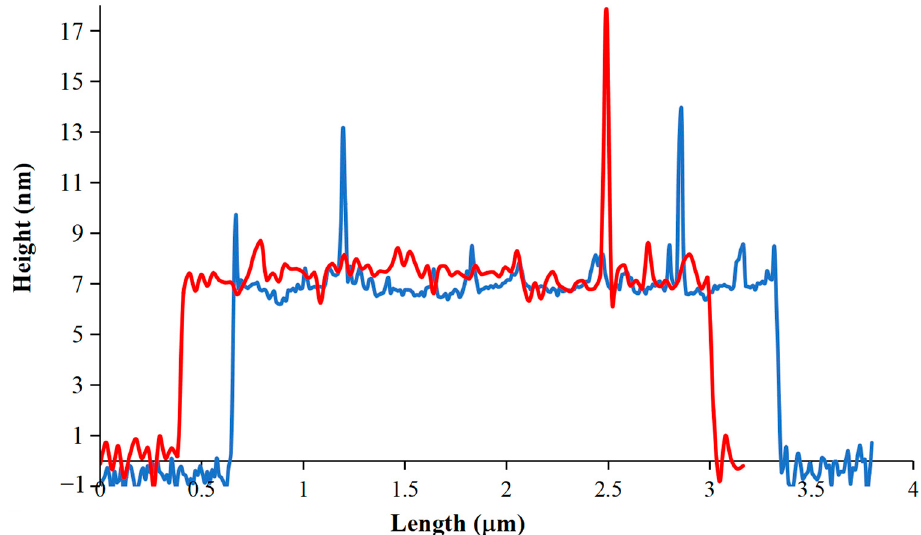
Figure 7. The heights of the wrinkles in Figure 6d (red dashed line) and Figure 6e (blue dashed line). In order to verify whether the generation of winkles is related to the thickness of the samples, two other samples of 5 nm thicknesses were investigated, as shown in Figure 8.